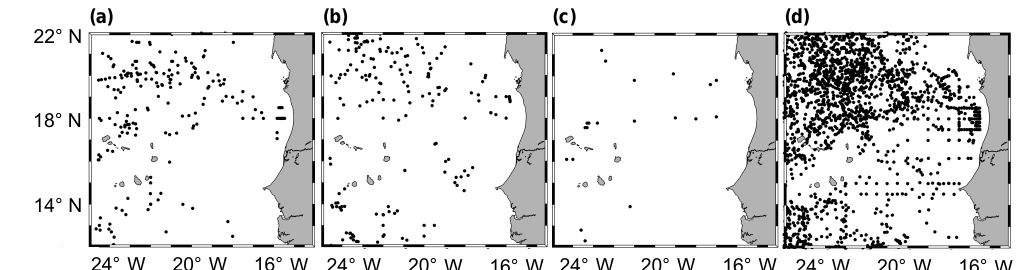
Figure 5. Location of all profiles taken in (a) cyclones, (b) anticyclones, (c) ACMEs, and (d) outside of an eddy.